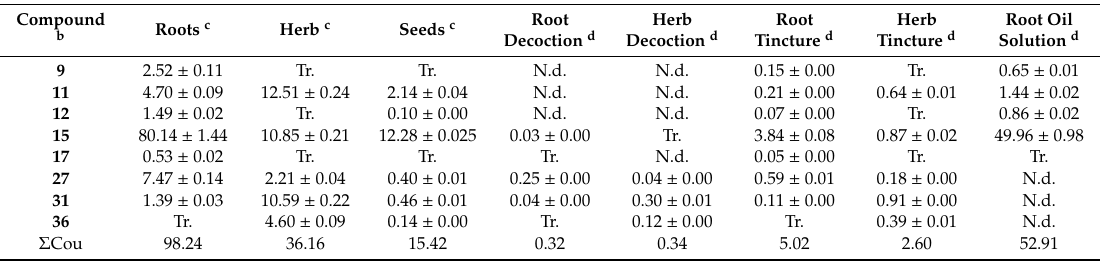
Table 3. Content of 8 compounds and sum of coumarins ( Σ Cou) in unprocessed P. sibiricus plant material and P. sibiricus preparations a . Compound c Herb c Seeds c Root b Roots Decoction